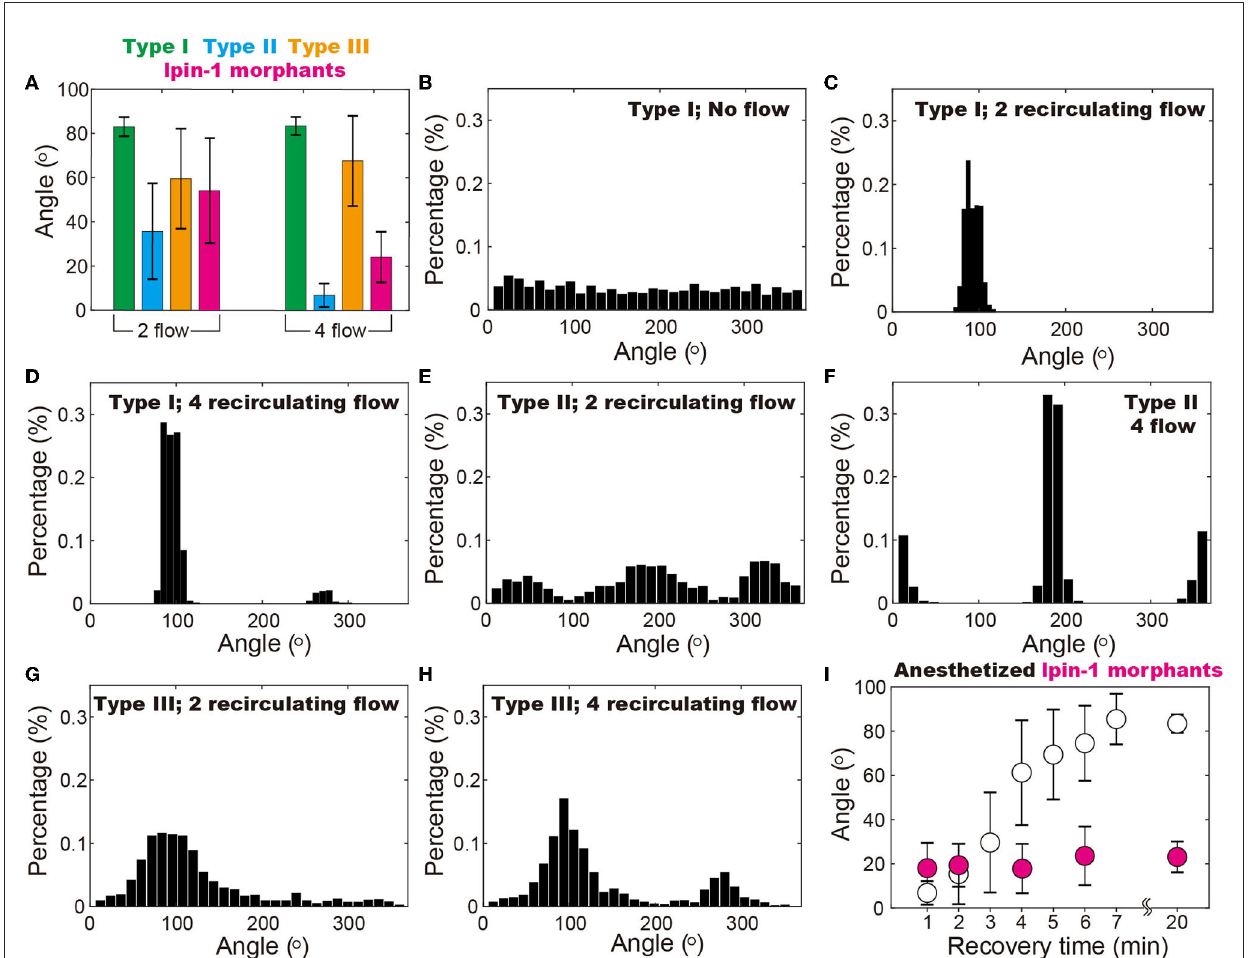
FIGURE5 Position of zebrafish in the vibrating droplet. (A) Positions of different types of zebrafish indicate that in the droplet with four recirculating flow zones, zebrafish with disrupted mobility (i.e., type II and the ones with lipin-1 deficiency) can be better distinguished from the wide type ones (i.e., type I) as compared to the two recirculating flow conditions. (B–H) Position (i.e., angle) distribution of different types of zebrafish in various flow patterns including two and four recirculating flow patterns. (I) In the four recirculating flow patterns, anesthetized zebrafish gradually regains mobility and moves from 0 ◦ to 90 ◦ within a time span of 20min. In contrast, zebrafish with lipin-1 deficiency remain immobile throughout the experiments. In (B) , each zebrafish was maintained in the droplet for 20min at 100% RH and 28.5 ◦ C to ensure that the random movement of zebrafish is recorded. Movements of 5–10 zebrafish are individually monitored in droplets with various flow patterns and also more than 50 zebrafish in droplets with no